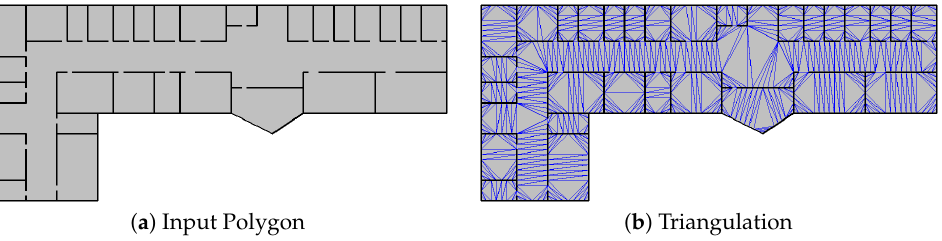
Figure 6. Input polygon and its triangulation.